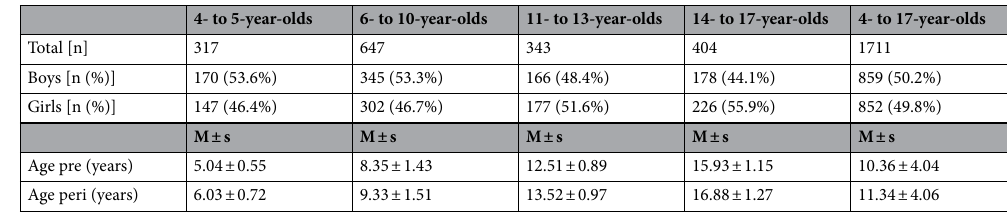
Table 5. Sample characteristics. M mean; s standard